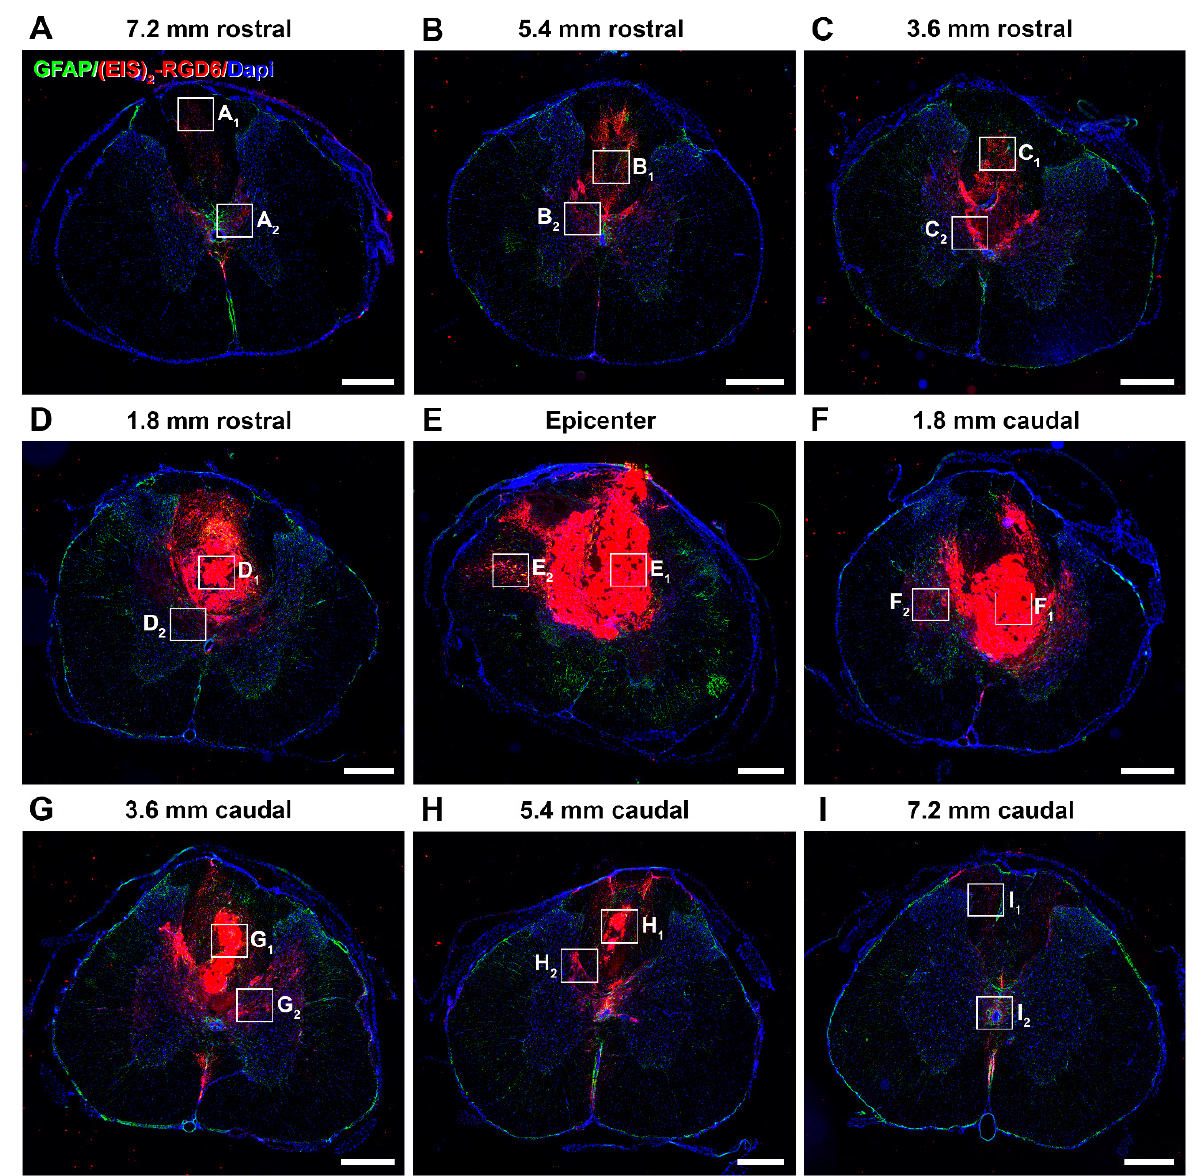
Figure 9. Qualitative microscopic analysis of (EIS) 2 -RGD6 distribution at 1 day post-injury. Repre- sentative images from whole spinal cord sections processed for the visualization of biotinylated (EIS) 2 -RGD6 and glial fibrillary acidic protein (GFAP) at 1 day post-injury [experiment (EIS) 2 -RGD6 II]. The following rostro-caudal spinal cord levels are shown: ( A ) 7.2 mm rostral; ( B ) 5.4 mm rostral; ( C ) 3.6 mm rostral; ( D ) 1.8 mm rostral; ( E ) 0 mm; ( F ) 1.8 mm caudal; ( G ) 3.6 mm caudal; ( H ) 5.4 mm caudal; and ( I ) 7.2 mm caudal from epicentre. Scale bars, 500 µm. Please note that higher magnifi- cation images corresponding to the areas highlighted with squares in ( A – I ) can be found in Figure 11.